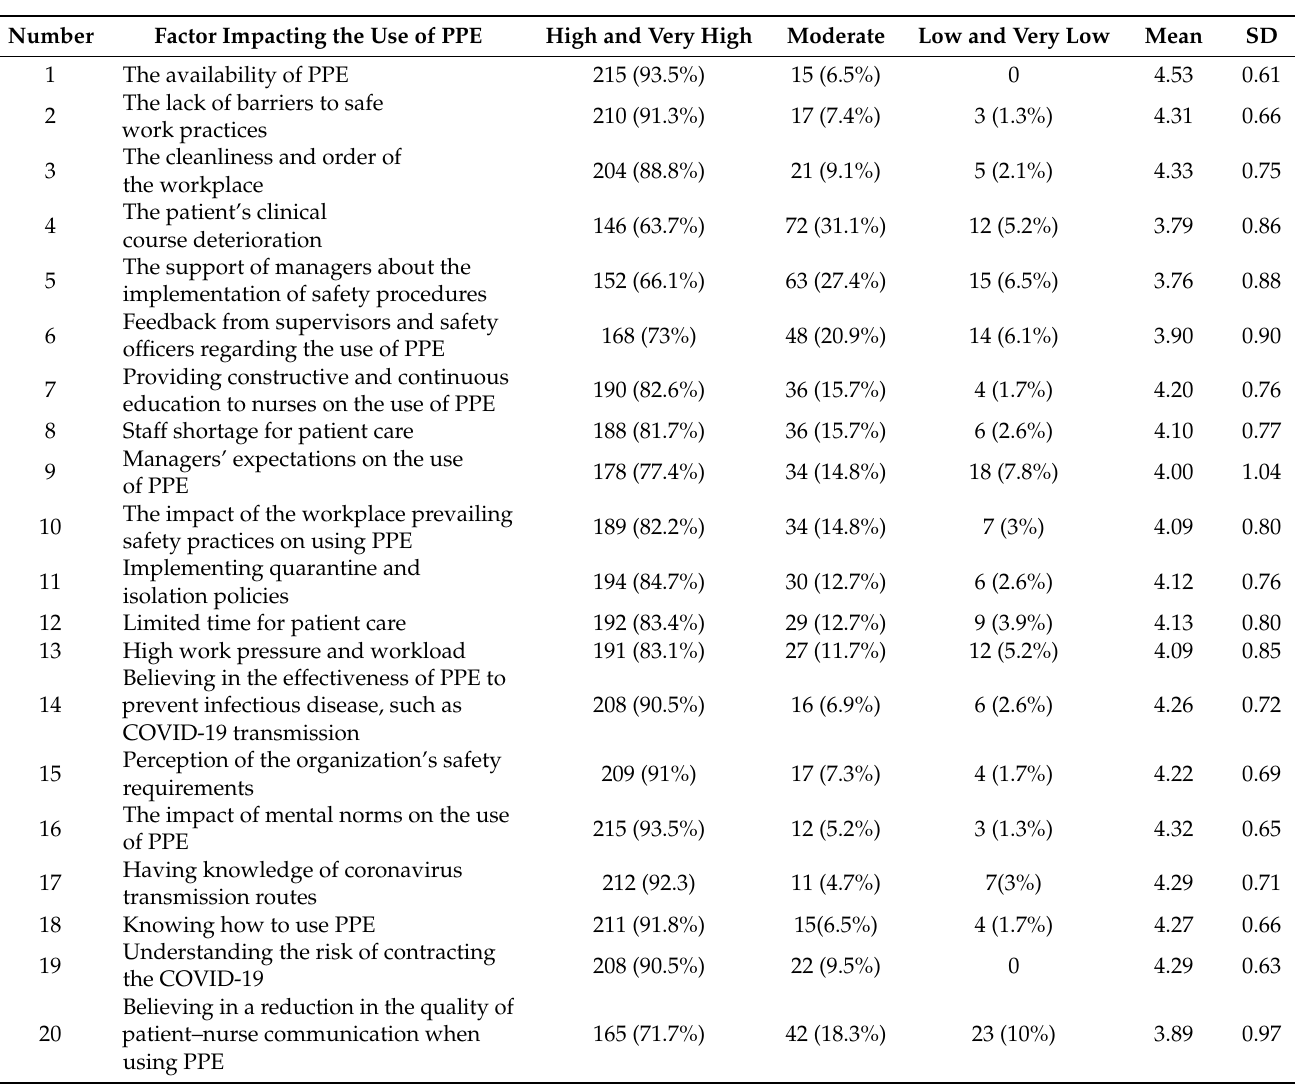
Table 5. Frequency, percentage, mean, and standard deviation of nurses’ responses to the factors affecting the use of personal protective